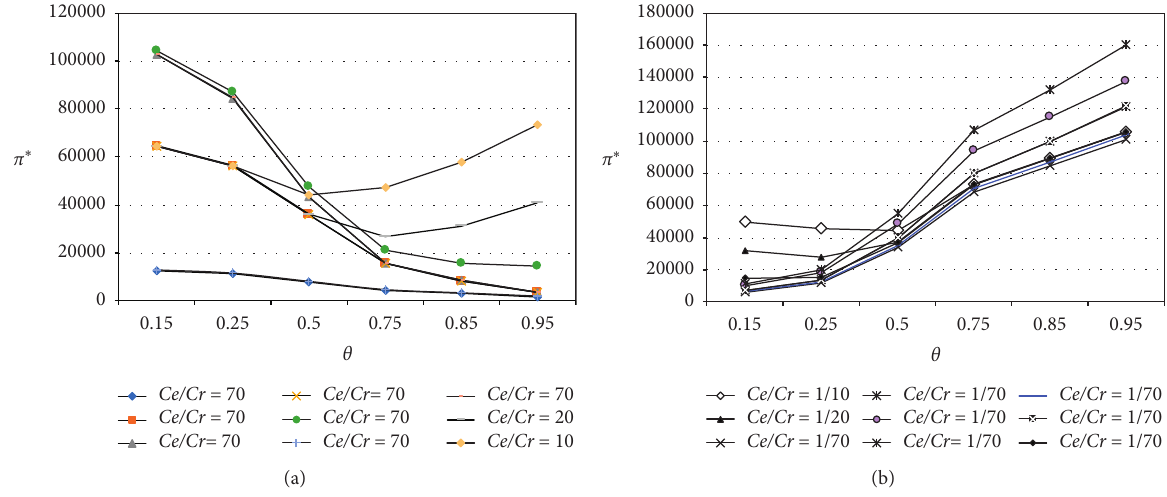
Figure 10: Comparison of the profitability of the firm according to different direct and retail channel operational costs. Table 6: The percentage of profit increases over P2 policy with no lead time flexibility. Problem